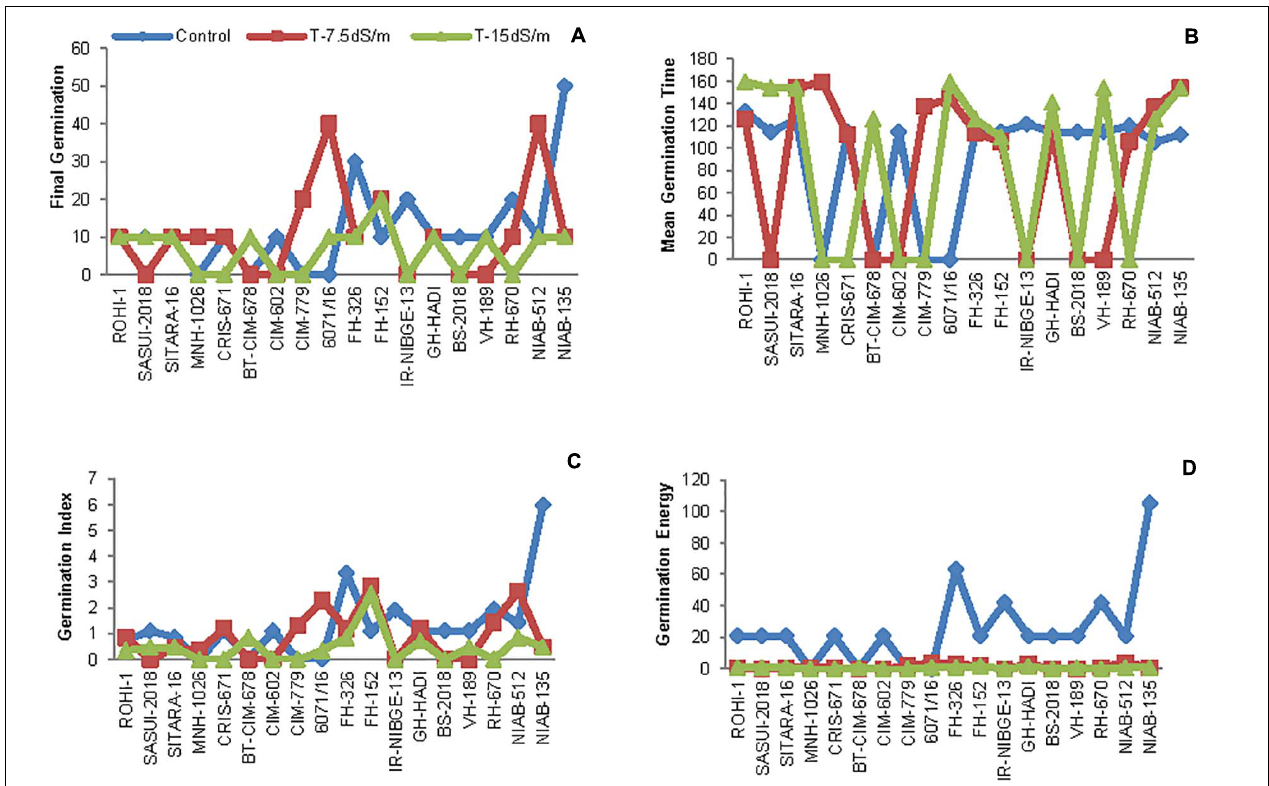
FIGURE 2 | (A) Final seed germination of cotton, (B) mean germination time (MGT), (C) germination index (GI), and (D) germination energy (GE) in growth chamber under control and salt stress